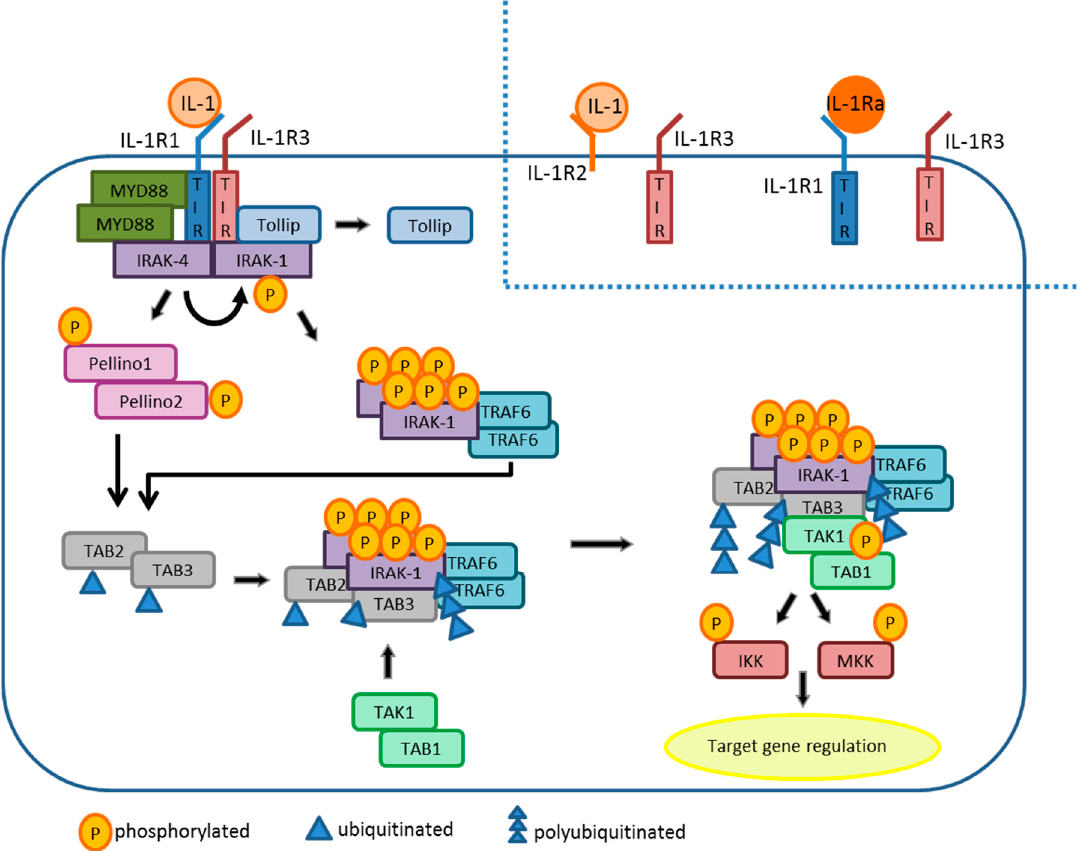
Figure 2. IL-1 signaling in target cells. Binding of IL-1 to IL1R1/3 results in cellular activation due to stimulation of IKK and MKK. IL-1 signaling is blunted in case of binding of IL-1 to the decoy receptor IL1R2/3, and by competitive binding of IL-1Ra to IL1R1/3.